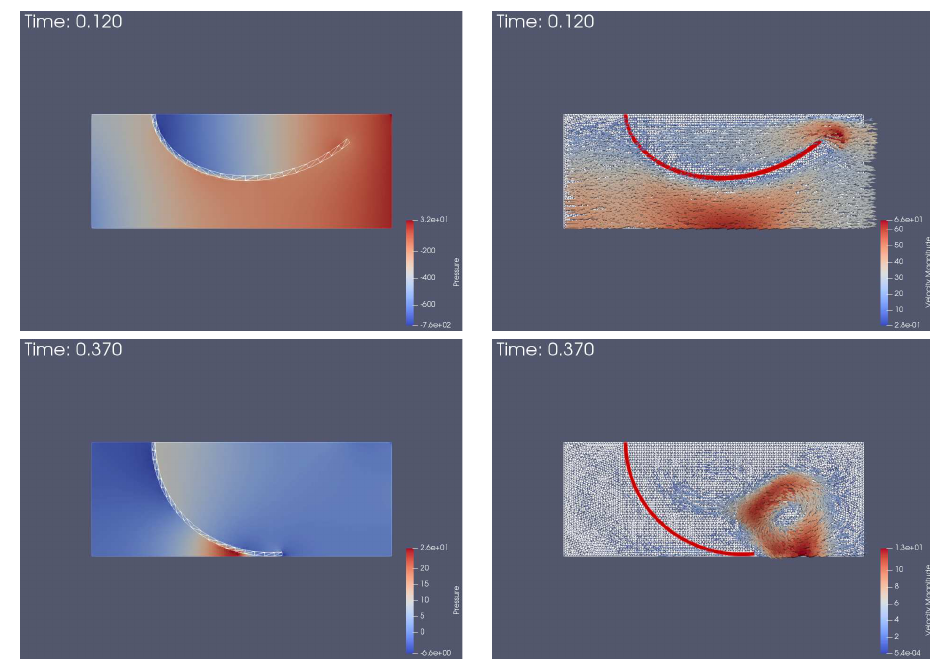
Figure 10. Computed solution for V max = 50, pressure ( left ) and velocity ( right ): when the valve was at the highest position t = 0.120 s ( top ) and when the valve made contact with the foundation t = 0.370 s ( bottom ).